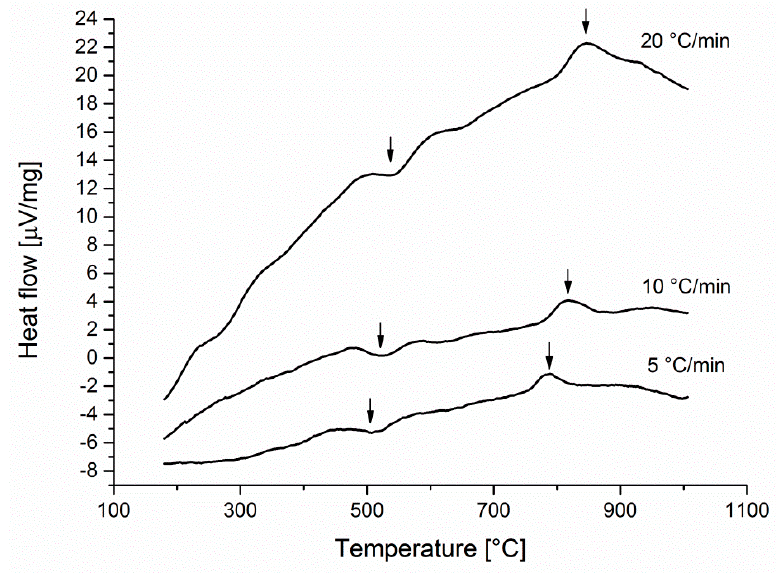
Figure 2. Di ff erential thermal analysis (DTA) curves with peaks at di ff erent heating Figure 2. Differential thermal analysis (DTA) curves with peaks at different heating speeds.